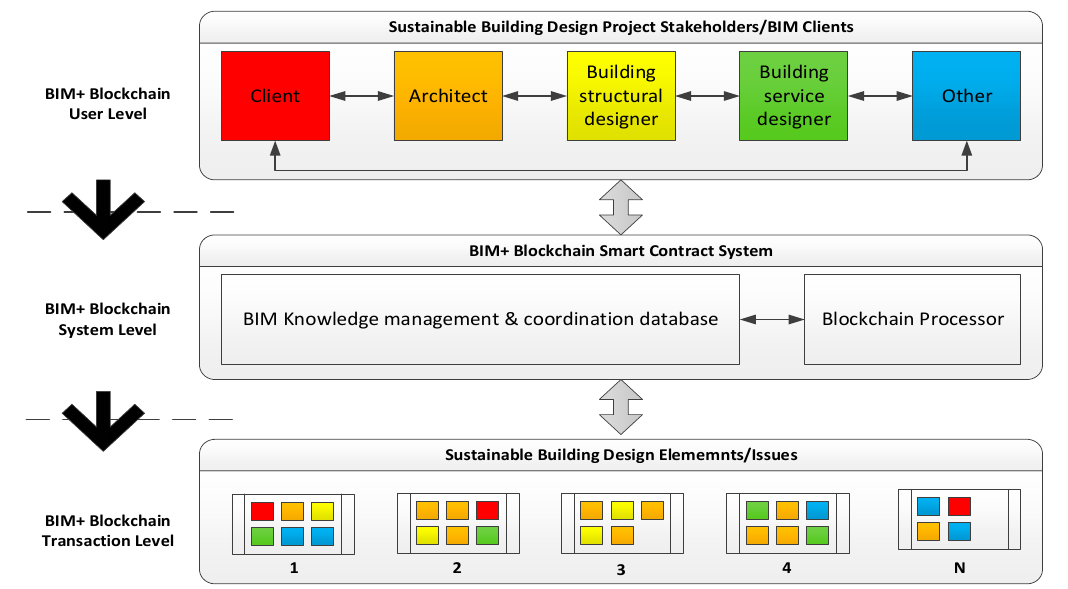
Figure 6. The user level driven BIM system for sustainable building design in information management of building construction project management (devised by the authors).